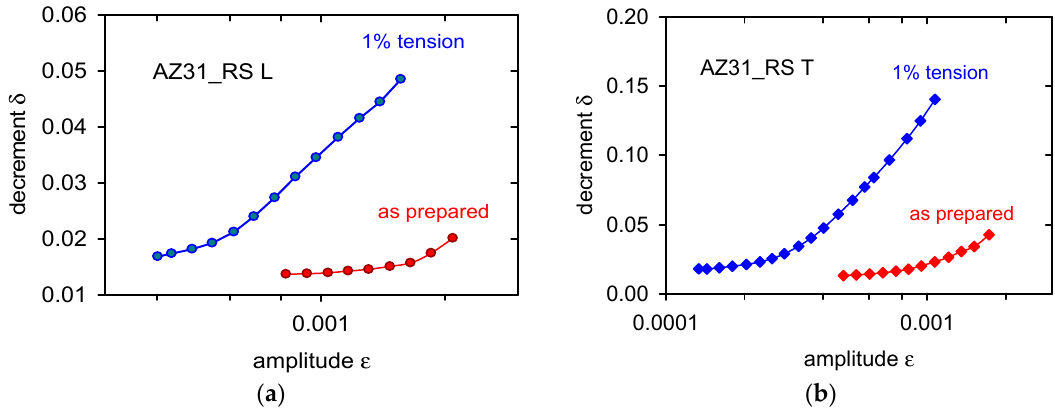
Figure 8. Influence of pre-staining in tension on ADIF: ( a ) L orientation; and ( b ) T orientation.